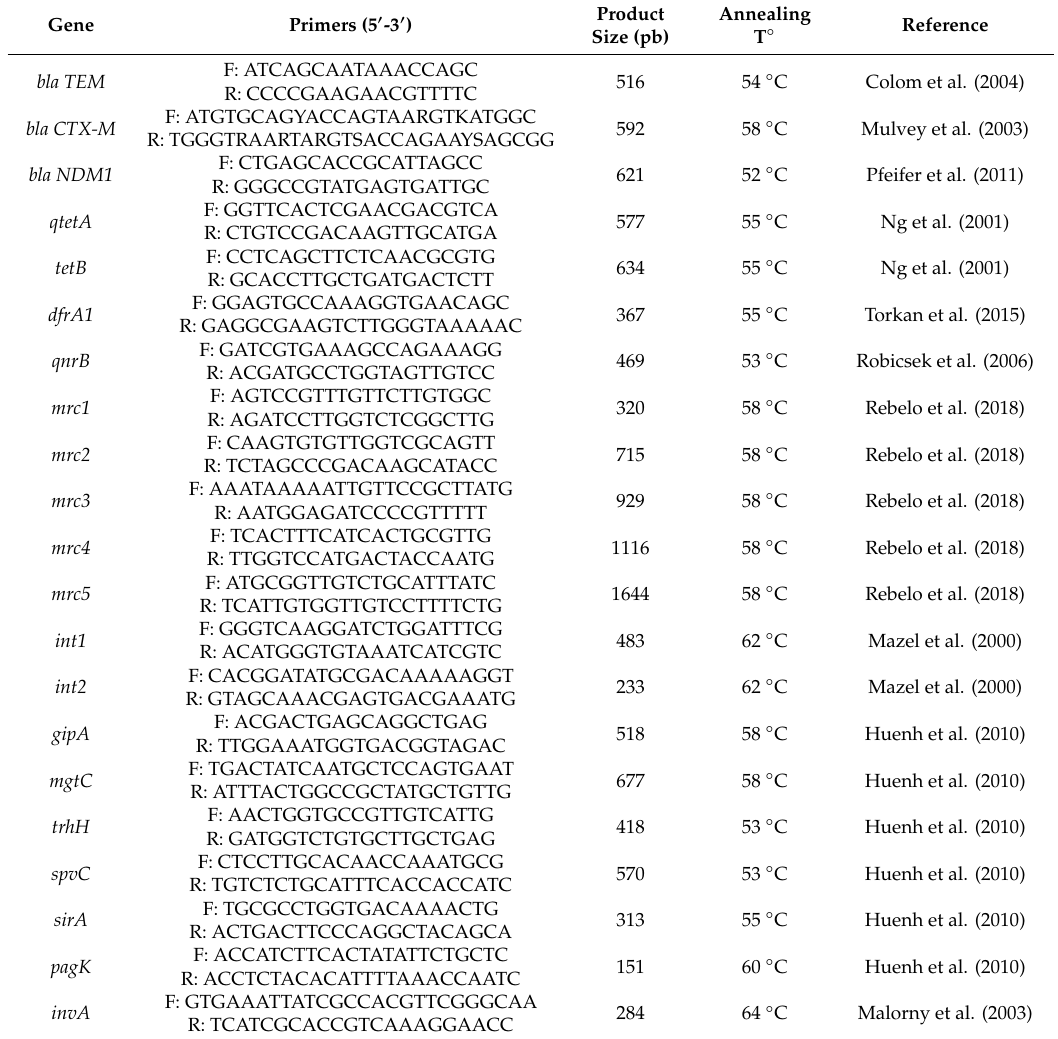
Table 1. Primers used to detect antimicrobial resistance and virulence